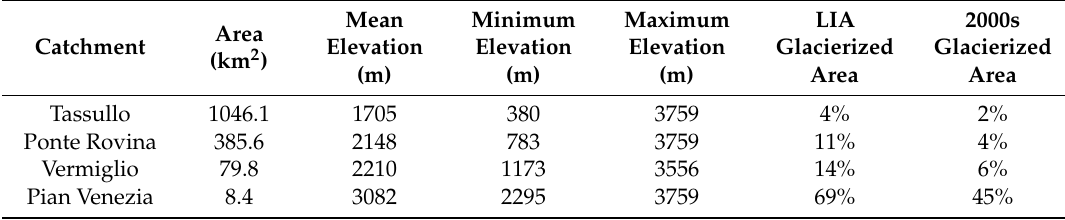
Table 1. Topographic characteristics of the four investigated catchments. LIA glacierized area